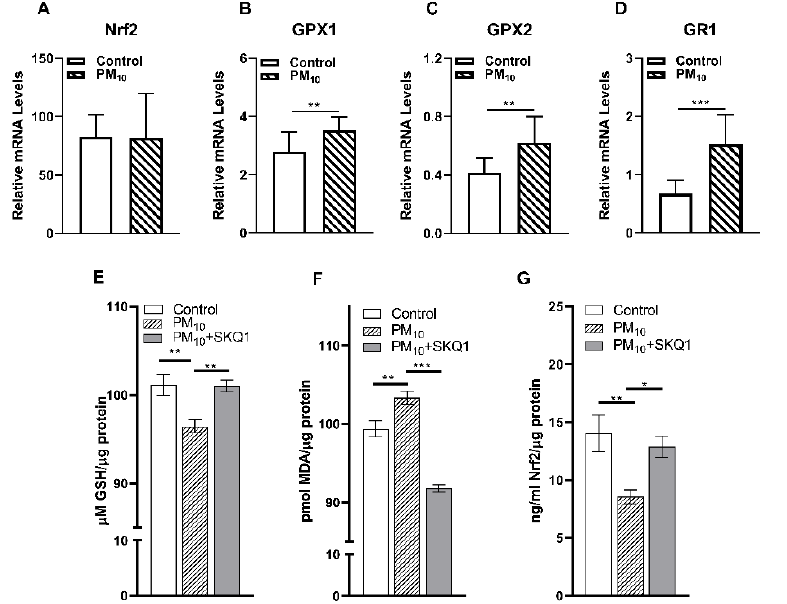
Figure 4. Effects of PM 10 on Nrf2, GSH maintenance enzymes; protective effects of SKQ1. mRNA levels for GSH maintenance enzymes: GPX1 ( B ), GPX2 ( C ) and GR1 ( D ) are significantly increased in PM 10 vs. control exposure at 2 weeks; no change for Nrf2 ( A ) levels. Effects of mitochondrial anti-oxidant SKQ1 on the levels of GSH, MDA and Nrf2 proteins after 2 weeks of PM 10 vs. control exposure ( E – G ). SKQ1 protects corneas by significantly increasing GSH (E), reducing MDA (F) and restoring Nrf2 (G) levels. Data are expressed as mean + SD. (* p < 0.05, ** p < 0.01, *** p < 0.001, n = 5/group).